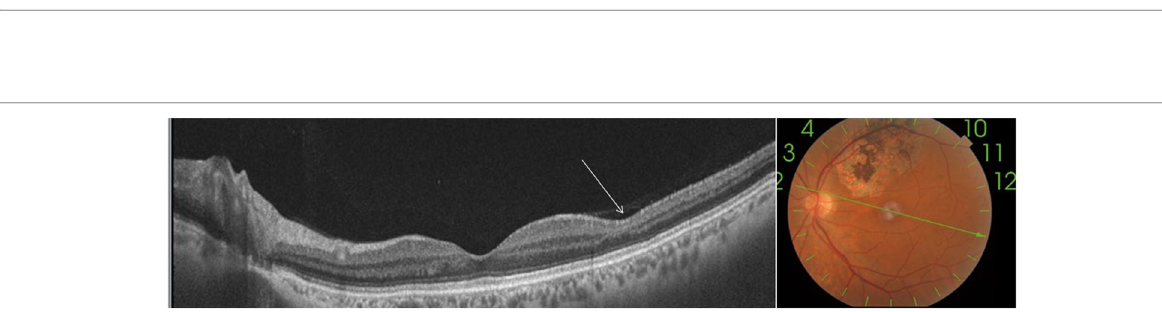
Fig. 4 Fundus photography taken six weeks after initial presentation shows a complete resolution of retinal hemorrhages and multifocal retinal lesions, without visible scarring